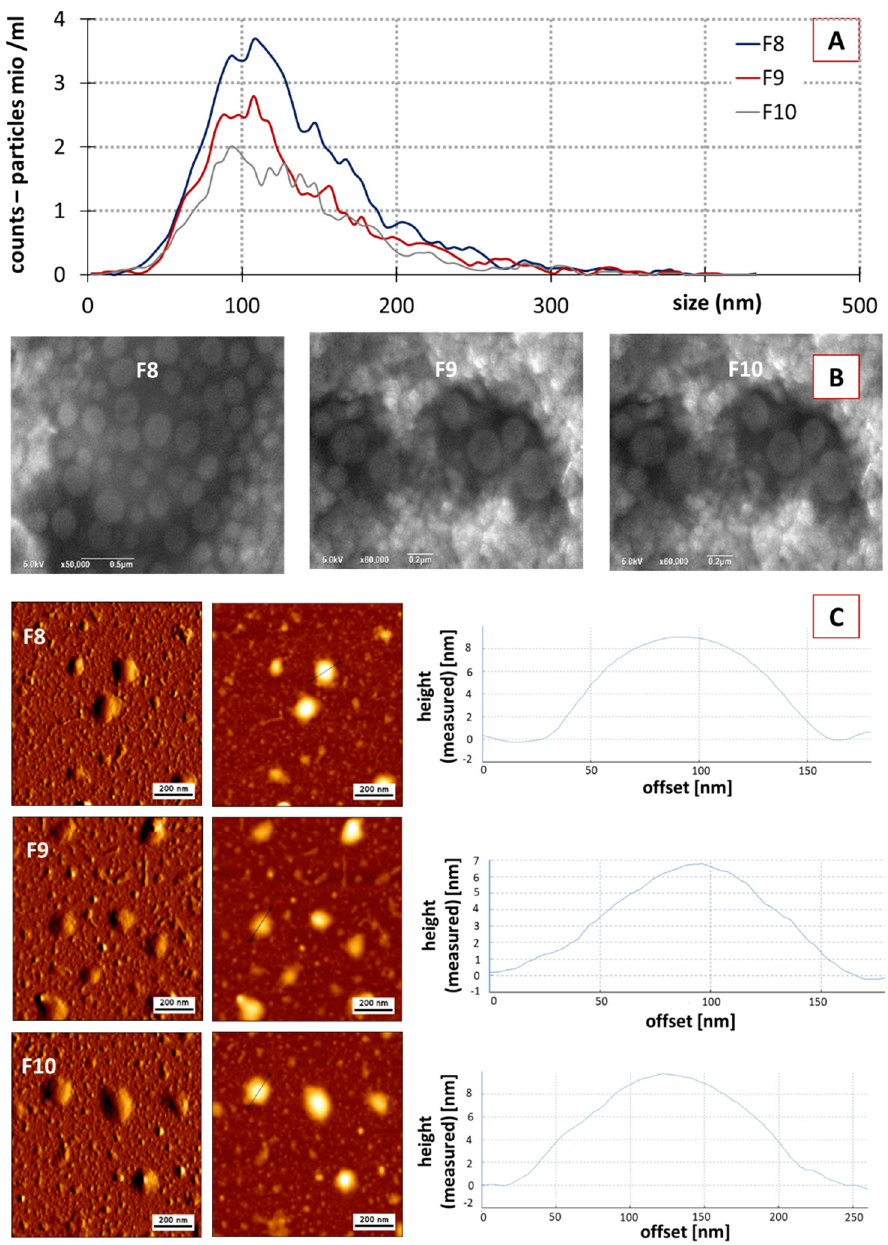
Figure 4. Physico-chemical characterization of fractions F8–F10 from purified classical PEVs. ( A ): NTA analysis, ( B ): SEM analysis, ( C ): AFM analysis. analysis, ( B ): SEM analysis, ( C ): AFM